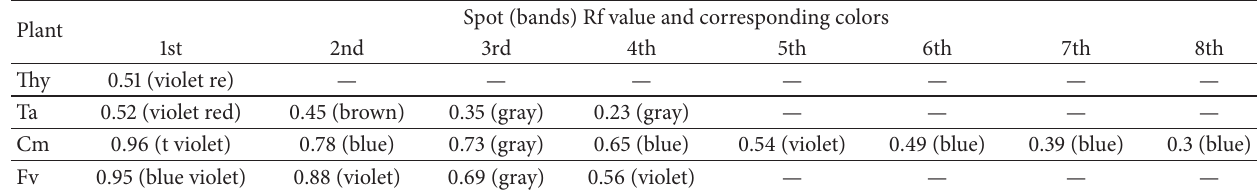
Table 1: TLC finger print of essential oils of aromatic plants.